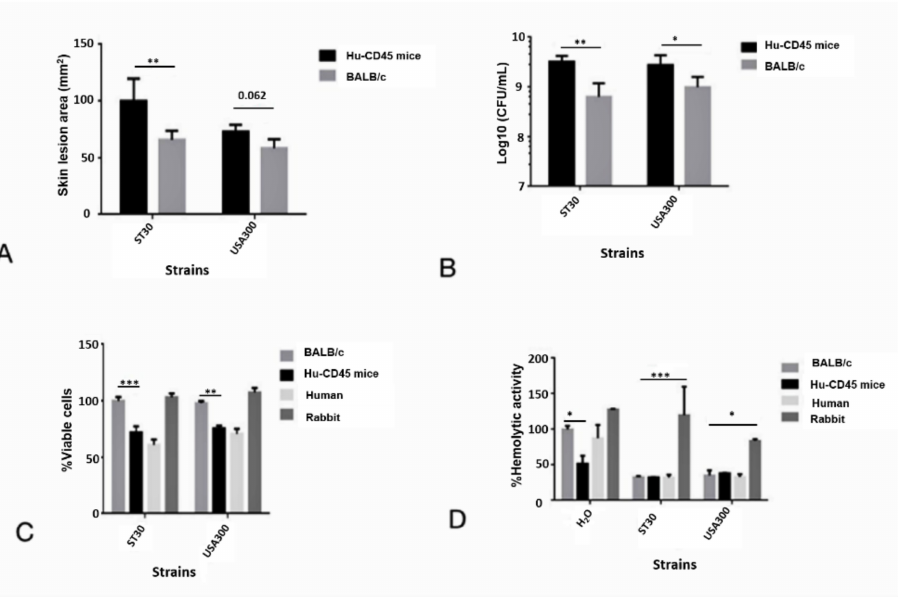
Figure 5. Humanized mice were more susceptible to MRSA ST30 strain. ( A ) The skin lesion sizes were defined by darkened areas of necrosis and calculated by V = Π x (L × W)/2, V is the size of the lesion, L is the length of the lesion, and W is the width of the lesion. Wildtype USA300 was used as control. Hu is the humanized mice. ( B ) Bacteria burden of mice after infection. ( C ) Neutrophil lysis activity of culture filtrate. Neutrophil lysis activity of wildtype ST30 strain in BALB/c was normalized to 100%. The error bars represent the standard deviation of the mean values, significance was determinant by two-way ANOVA ( D ) Hemolysis by bacterial culture filtrate. Hemolytic activity of H 2 O in BALB/c was normalized to 100%. The error bars represent the standard deviation of the mean values, significance was determinant by Two-way ANOVA. * indicate the significant difference between humanized mice and rabbit within each strain, and coded as * p < 0.05, ** p < 0.01, *** p <